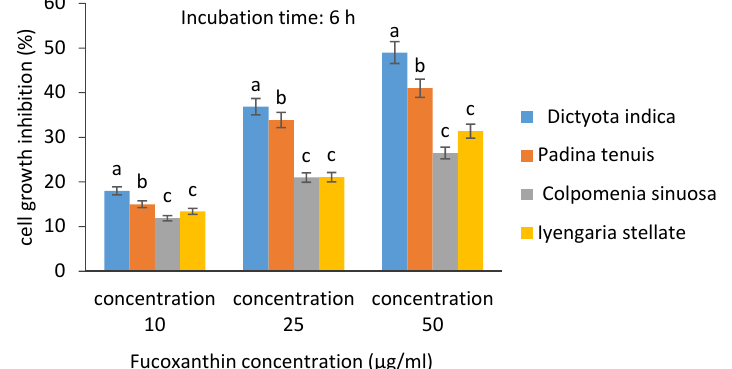
Fig. 2: Percentages of cell growth inhibition at different concentrations of fucoxanthin extract from fourspecies of brown seaweeds (P. tenuis , C. sinuosa , I. stellate and D.Indica) at 6 h incubation time. Data are expressed as mean±standared deviation (n=3). Different letters (a, b, c) indicate significant mean differences between seaweeds species at a level of p < 0.05